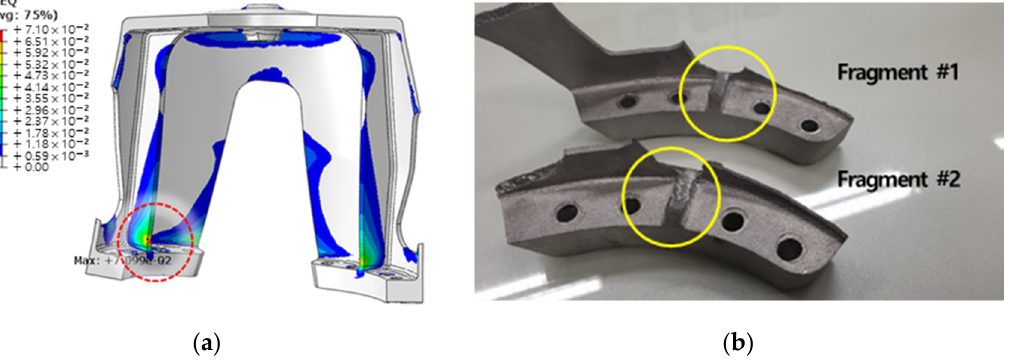
Figure 14. Prediction of the starting location of damage through structural analysis: ( a ) confirmation of high equivalent plastic strain at flange position; ( b ) the location of the failure identified in the fragments of the experiment.